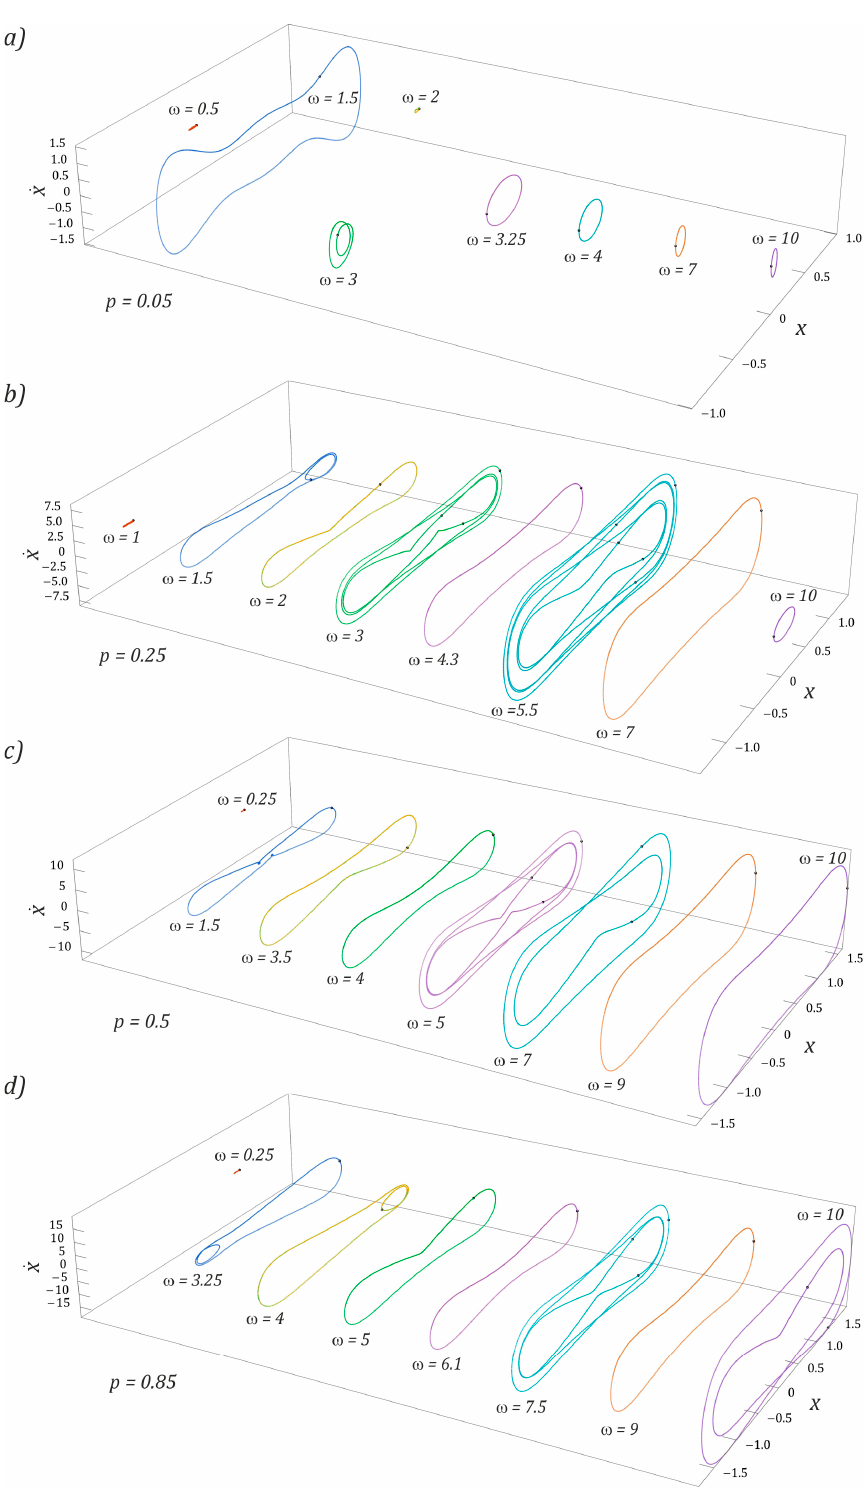
Figure 10. Influence of external load characteristics on periodic induced solutions (see the shape and size of the corresponding phase portrait (𝑥, 𝑥(cid:4662)) ) in a TEH. ( a ) p = 0.05, ( b ) p = 0.25, ( c ) p = 0.5, and ( d ) p = 0.85. Trajectory shapes are plotted for selected frequencies, ω . ω , p , x, and 𝑥(cid:4662) are dimensionless.